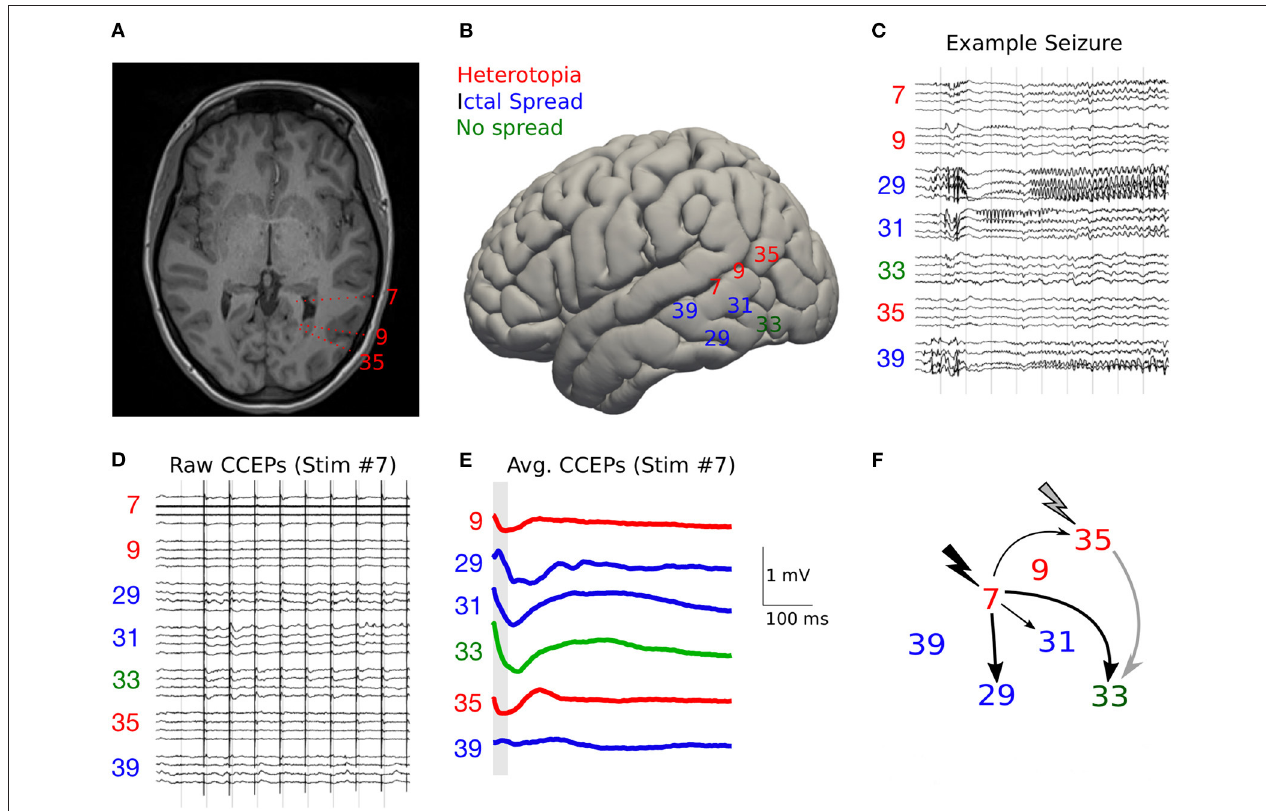
FIGURE 4 | Example of using CCEPs to study effective connectivity. (A) Axial MRI Brian (T1) showing two periventricular nodular heterotopias in the tirgone of the left lateral ventricle and the trajectories of electrodes 7, 9, and 35, with dashes showing the approximate location of the 10 contacts of each recording electrode. (B) The approximate lateral entry points of pertinent left-sided SEEG electrodes are shown as electrode numbers. (C) An example spontaneous left sided seizure onset is shown with gamma activity on electrode 29 contacts 1–3 (posterior hippocampus). (D) Raw cortico-cortical evoked potentials (CCEPS) triggered by 1Hz bipolar stimulation anterior heterotopion (electrode 7 contacts 3–4). Evoked potentials with peak to trough amplitude > 250 µ V are evident on electrodes 29, 31, and 33. (E) Averaged CCEPs with 20–50ms (gray bar) window of interest shown. Only the largest amplitude (root mean squared amplitude (RMSA) CCEP (taken over all 10 contacts) is shown for each electrode. (F) Connectivity map for stimulation to electrode 7 (black) and 35 (gray). Thick arrows represent CCEPs with RMSA > 200mV, thin arrows represent CCEPs with RMSA > 100mV. From Dickey et al.